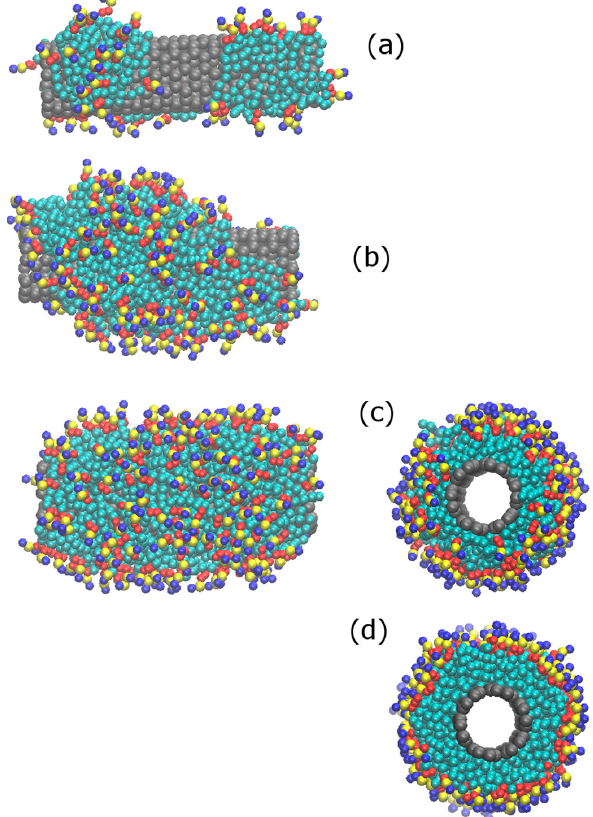
Figure 6. Snapshots of a simulation box indicating surface density dependence of ordering of DPPC lipid molecules around the CNT (20, 20). In snapshots ( a – d ), the surface densities of lipid molecules are 0.28, 0.83, 1.05, and 1.22 (corresponding to 0.56 nm − 2 , 1.64 nm − 2 , 2.09 nm − 2 , and 2.43 nm − 2 , respectively).